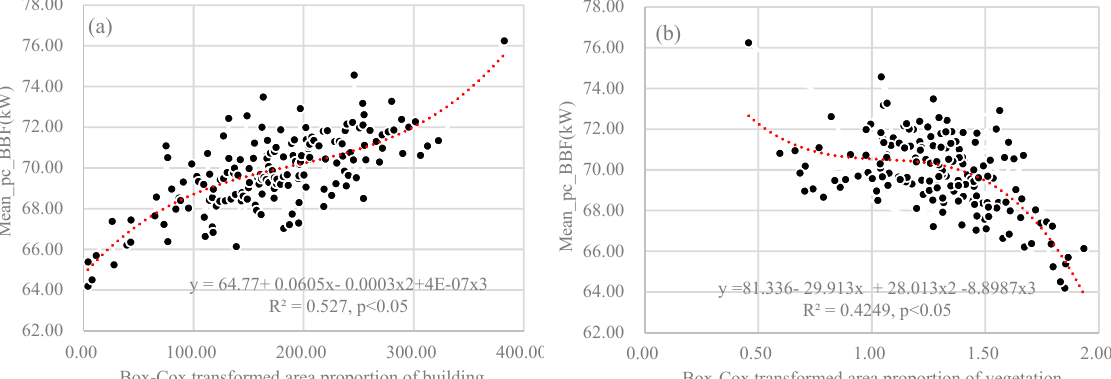
Figure 5. Non-linear regression models showing the statistical relationships between ( a ) Box–Cox transformed area proportion of building and Mean_pc_BBF; ( b ) Box–Cox transformed area proportion of vegetation and Mean_pc_BBF. Note: Given the high correlation between the Box–Cox transformed variables and Mean_pc_BBF (see Table 2) that causes the multicollinearity, only two of them were selected to draw the